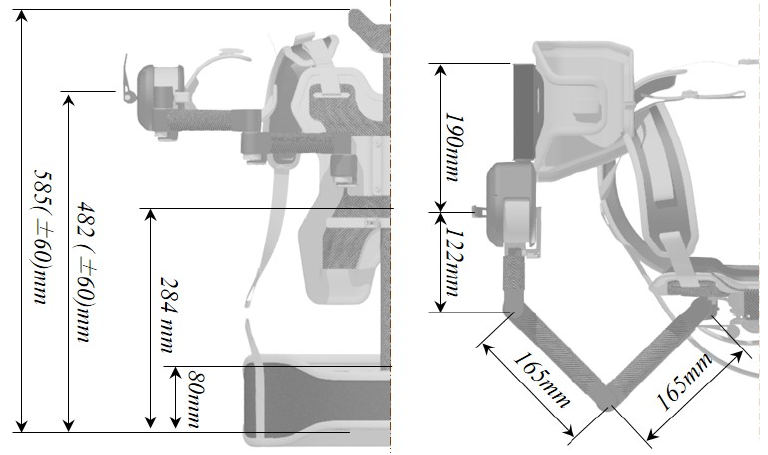
Figure 8. Detailed illustration of the lightweight structure.